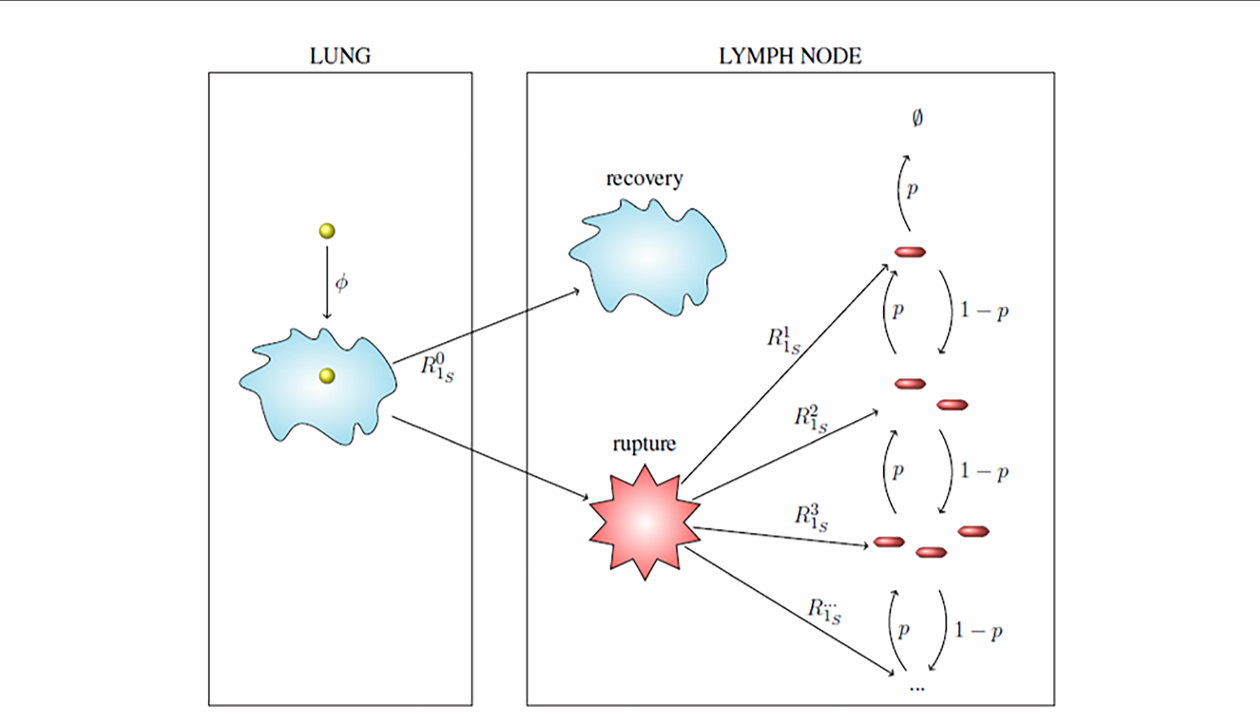
FIGURE 9 | Toy model for the possible fates of a single spore in the early stages of inhalational anthrax infection. Within the lung, an inhaled spore (yellow ball) becomes deposited with probability f and is ingested by a host phagocyte. The intracellular spore germinates and the phagocyte might kill the germinated bacterium or the bacterium may survive the antimicrobial environment, replicate and cause the phagocyte to rupture, as described in the intracellular model. The infected phagocyte migrates to the lymph nodes and either recovers or ruptures and releases some bacteria, according to the probabilities calculated with the intracellular . The population of bacteria released follows a birth and death process, where an extracellular bacterium may be killed by host immune cells with model, R n 1 S probability p or a bacterium will replicate extracellularly with probability 1 - p , until either there are no extracellular bacteria remaining, or the population of extracellular bacteria reaches a threshold M